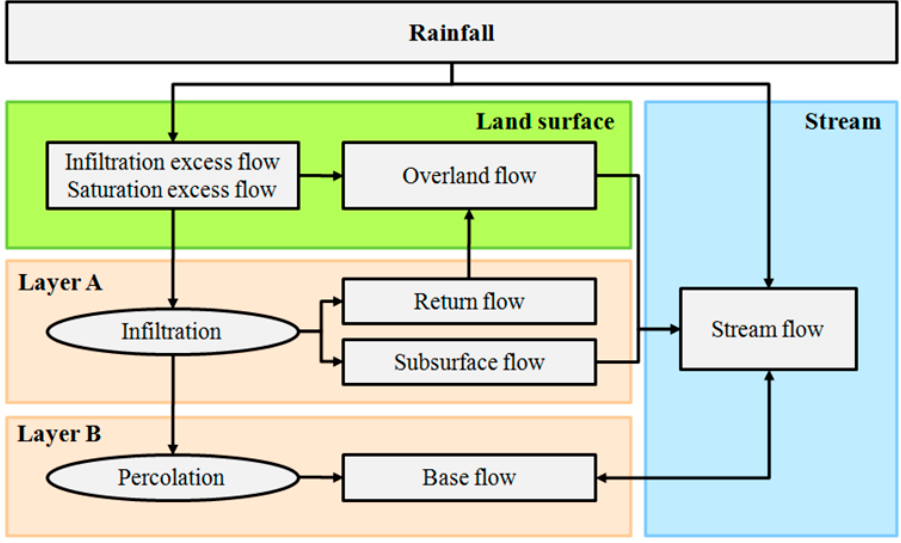
Figure 3. Schematic of grid-based rainfall-runoff method (GRM) [40].